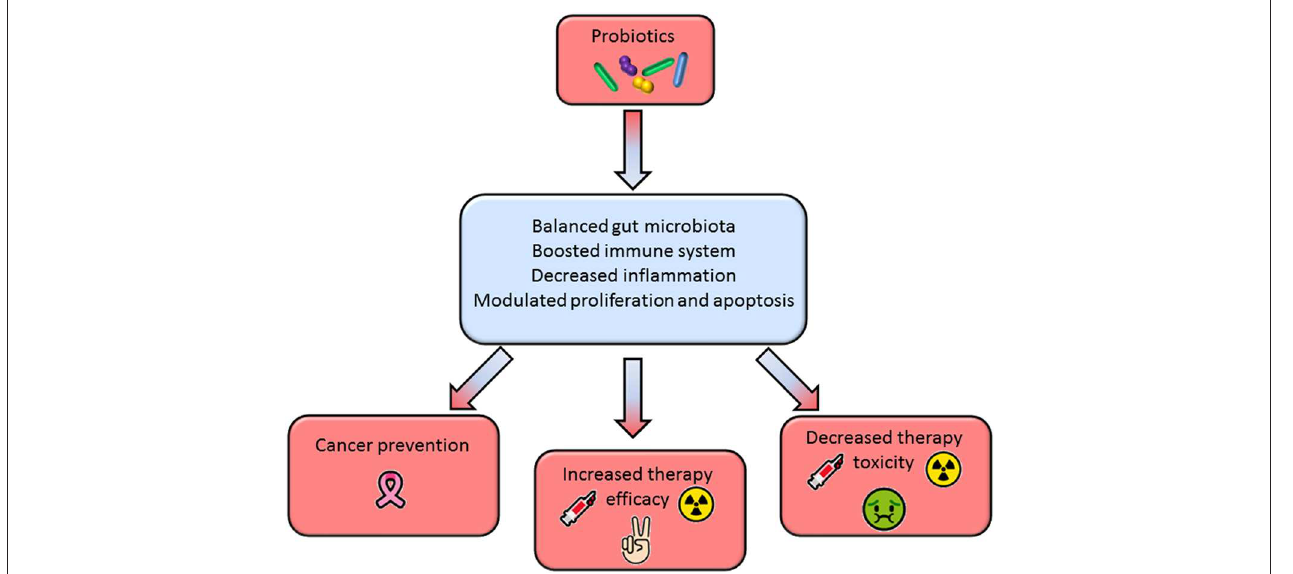
FIGURE 1 | Beneficial effects of probiotics administration in cancer prevention and therapy.